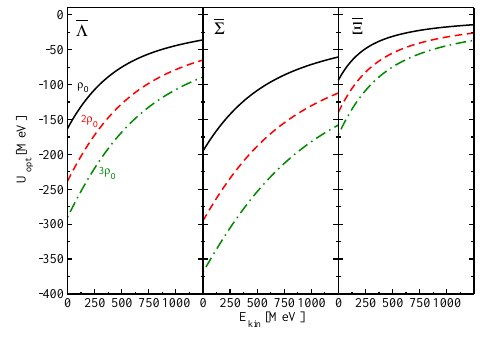
Figure 8. Optical potentials for anti-hyperons versus their kinetic energy for symmetric nuclear matter (SNM) at various densities, as indicated. The NLD predictions for saturation density ρ 0 (solid) and higher densities of 2 ρ 0 (dashed) and 3 ρ 0 (dashed-dot) are